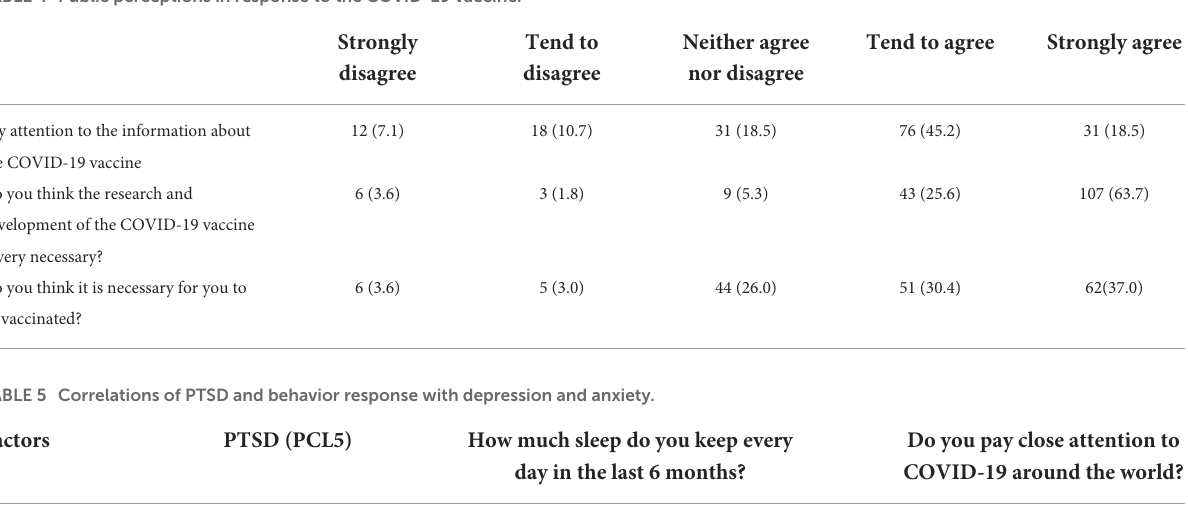
TABLE 4 Public perceptions in response to the COVID-19 vaccine.